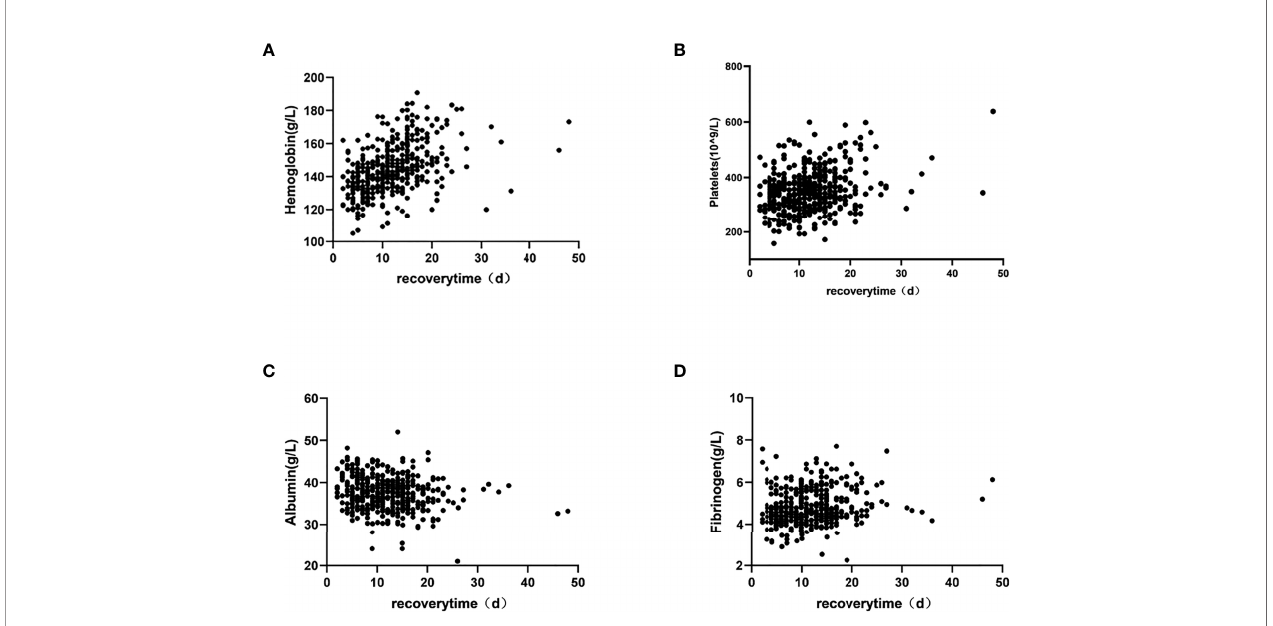
FIGURE 2 | Relationship between the recovery time and hemoglobin, platelets, albumin and